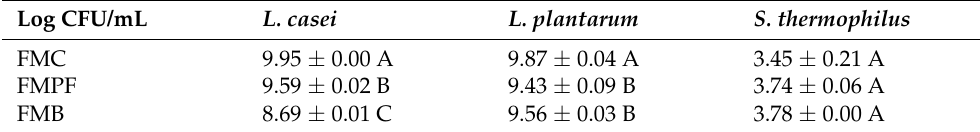
Table 1. Viability of lactic acid bacteria (Log CFU/mL) of FM assessed in SHIME ® . Log CFU/mL L.